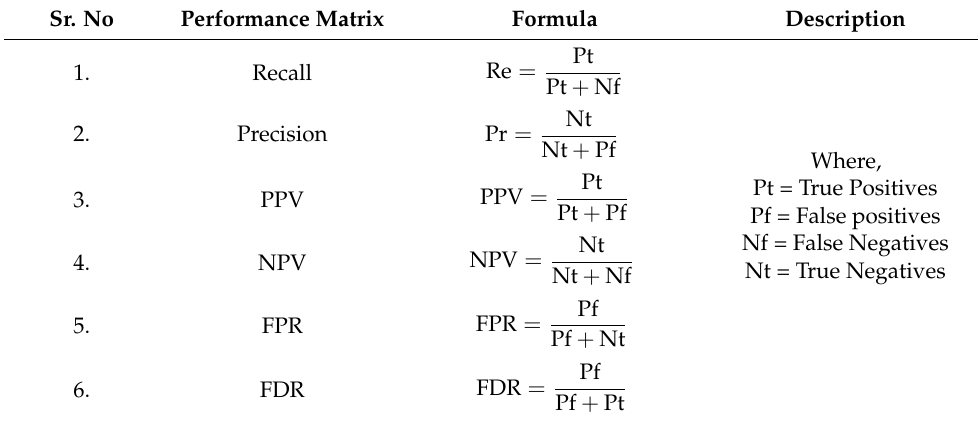
Table 2. Performance matrices.